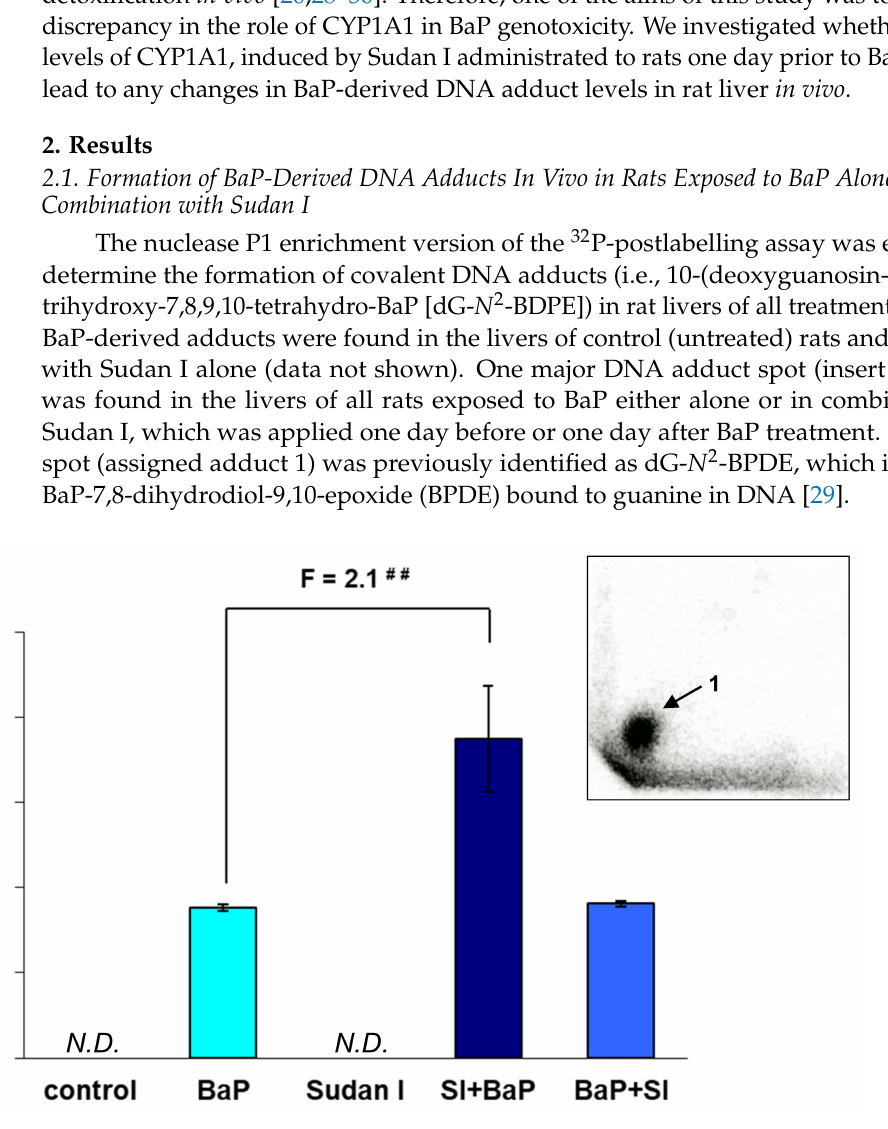
Figure 2. Quantitative TLC- 32 P-postlabelling analysis of DNA adducts in livers of control (untreated) rats and rats treated with BaP alone, Sudan I alone, Sudan I before BaP treatment (SI + BaP) or Sudan I after BaP treatment (BaP + SI). Number above columns (“F”) indicates fold change in DNA adduct level in comparison to animals treated with BaP alone. The values represent mean ± S.D. of three liver samples/group; each DNA sample was determined by two 32 P-postlabelling analyses. Statistical comparison was performed by t-test analysis; ## p < 0.01—results significantly different from animals treated with BaP alone. N.D. —not detected. Insert: Representative autoradiogram showing the dG- N 2 -BPDE adduct (assigned adduct 1) formed in livers of rats treated with BaP; the origin on the TLC plate, at the bottom left-hand corner, was cut off before